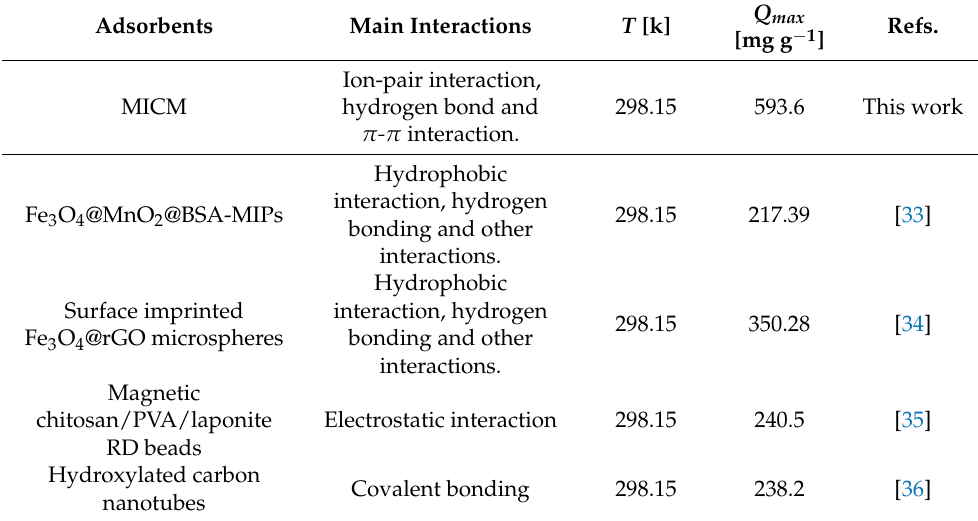
Table 5. A comparison of the maximum adsorption capacity of different adsorbents for BSA.